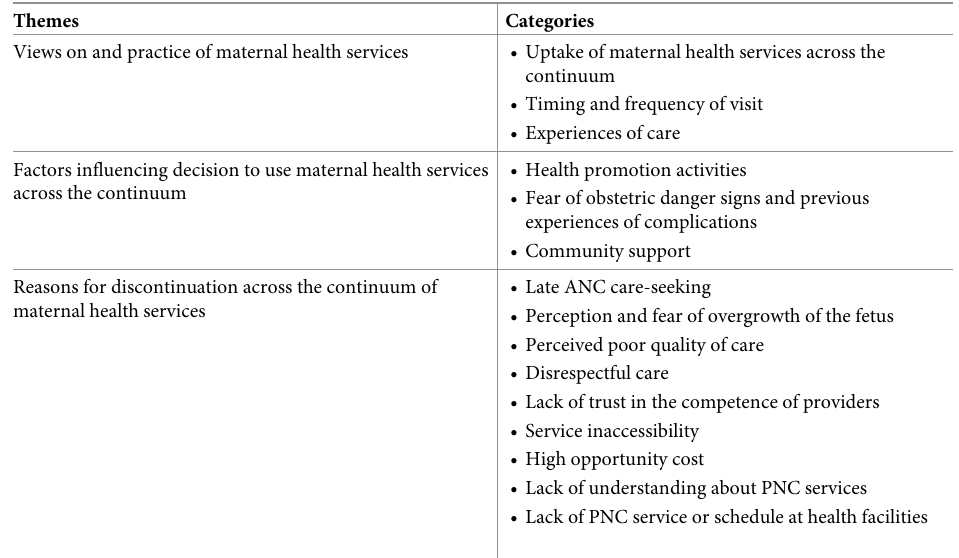
Table 1. Major themes and categories